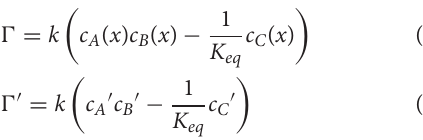
Frontiers in Chemical Engineering |